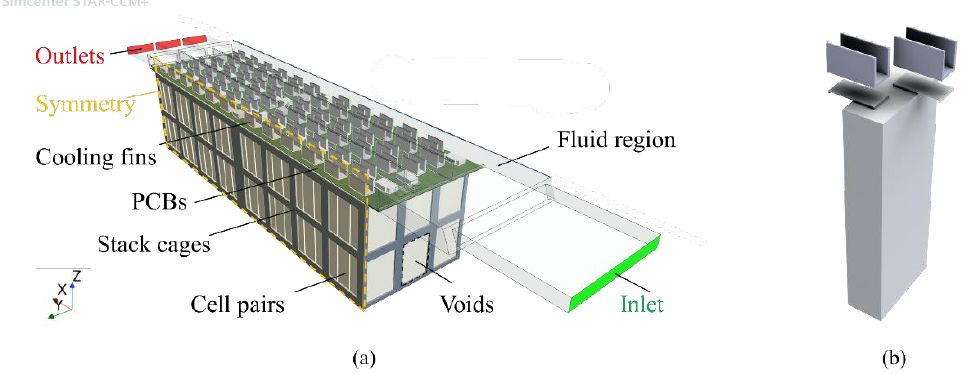
Figure 8. ( a ) Fluid and solid regions in the CFD model and ( b ) exploded view of the cell, tabs and the cooling fins. cooling